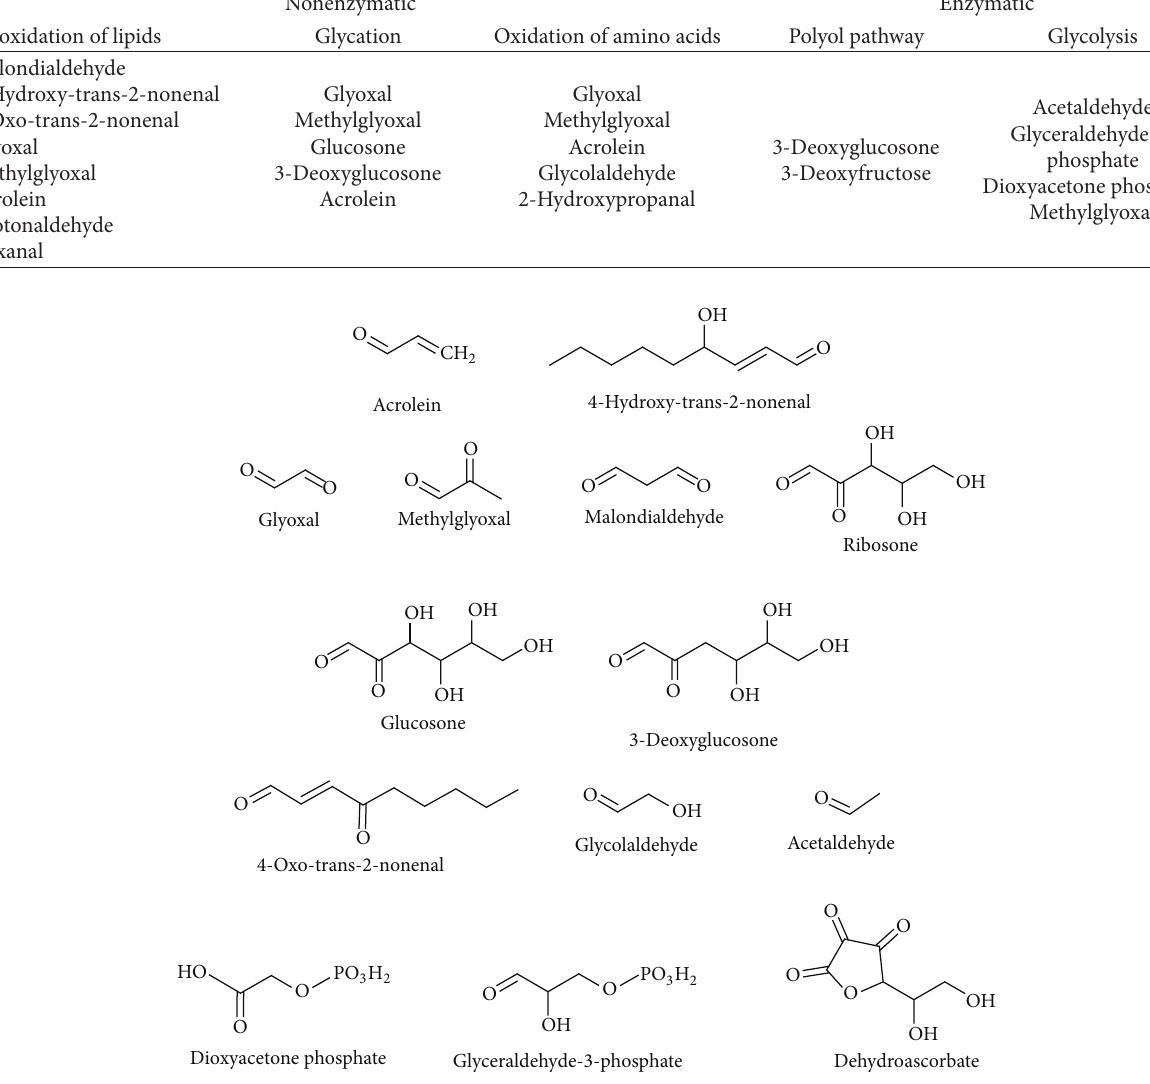
Figure 1: The structures of most common biological reactive carbonyl